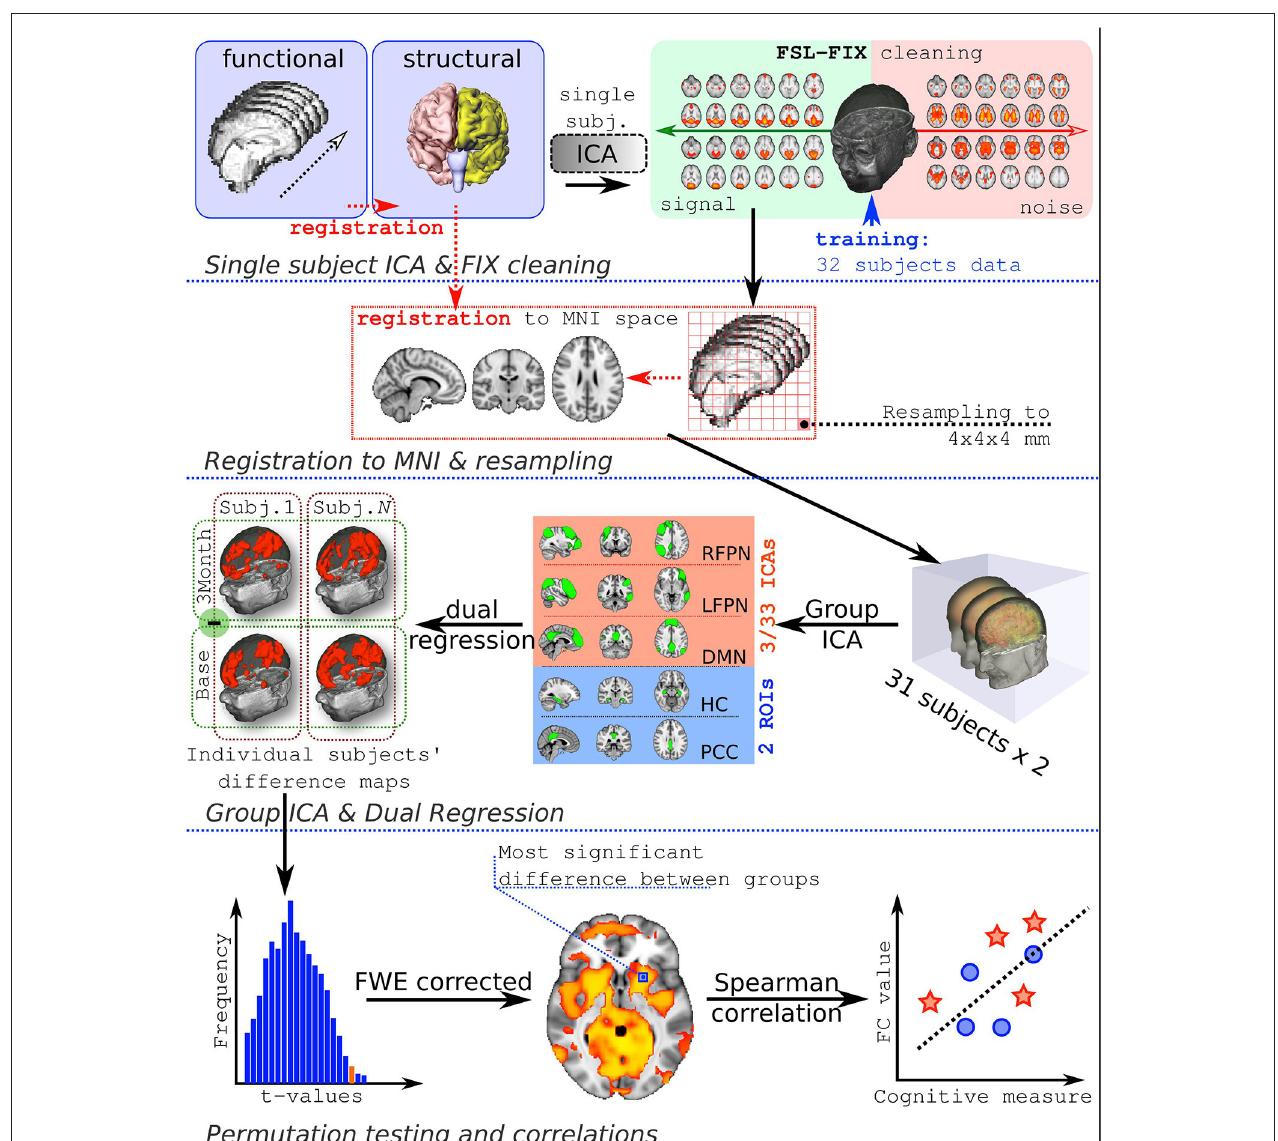
FIGURE 1 | Analysis workflow. FC, functional